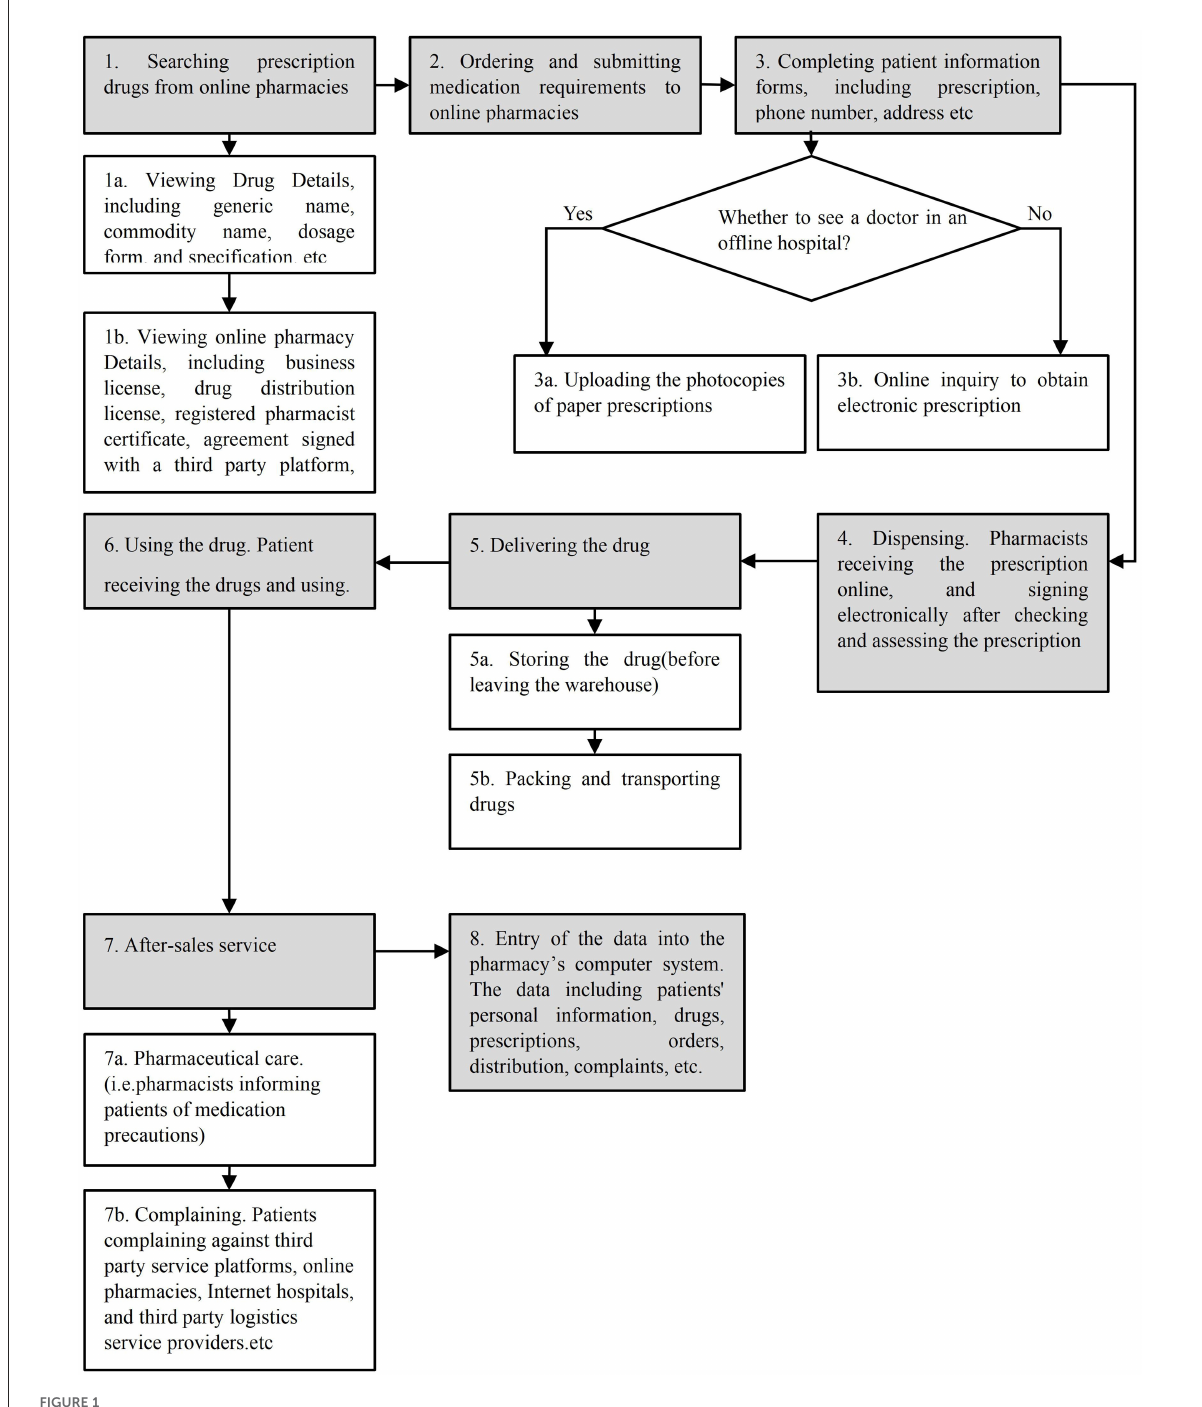
the drug and 16.67% (5/30) were from Step 1, searching prescription drugs in online pharmacies; four failure modes were from Step 3, completing patient information forms; Step